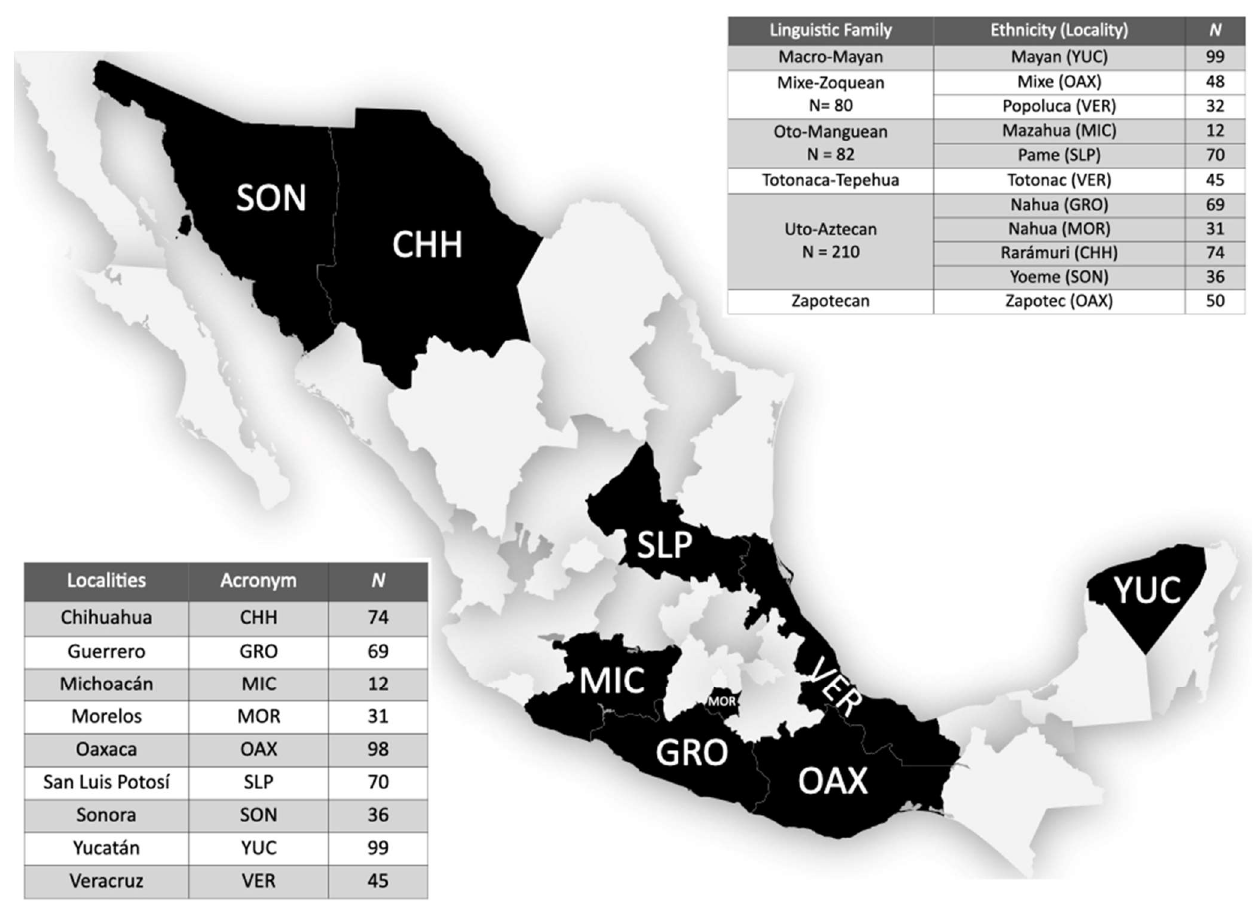
Figure 1. Map of Mexico showing the geographical origin of Mexican Native American populations included in the present study. The states where MNA populations live are shaded in black. N -number of subjects.